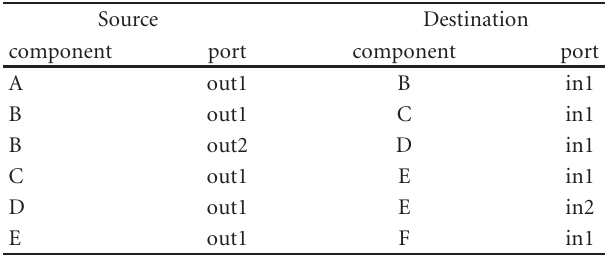
Table 1: Port connection table for Figure 1.